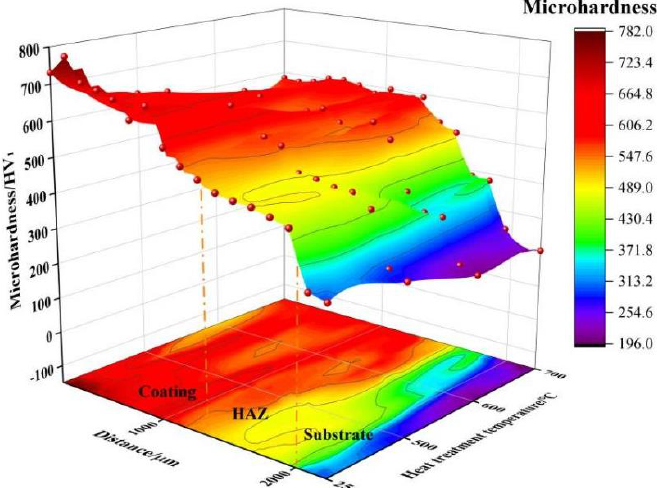
Figure 6. Microhardness distribution of the composite coatings with different thermal treatment temperatures.